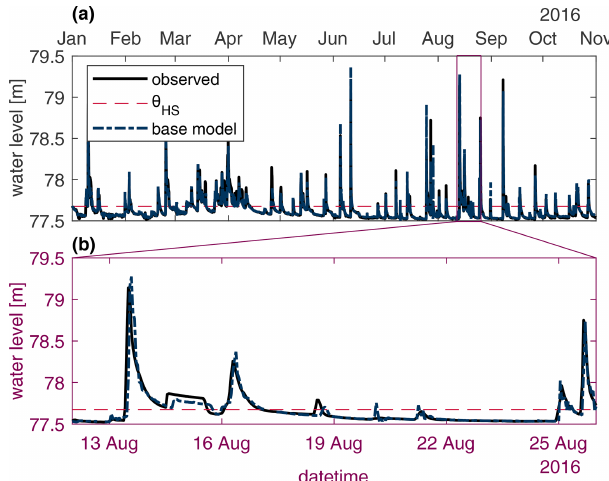
Figure 4. Observed and individual learner stage predictions for the Don River system for all 10 months of an available stage (a) and a 14d subset which contains a particularly high stage (b) to better distinguish the two hydrographs. The dashed red line indicates the fixed threshold used to distinguish between typical and high stage values.